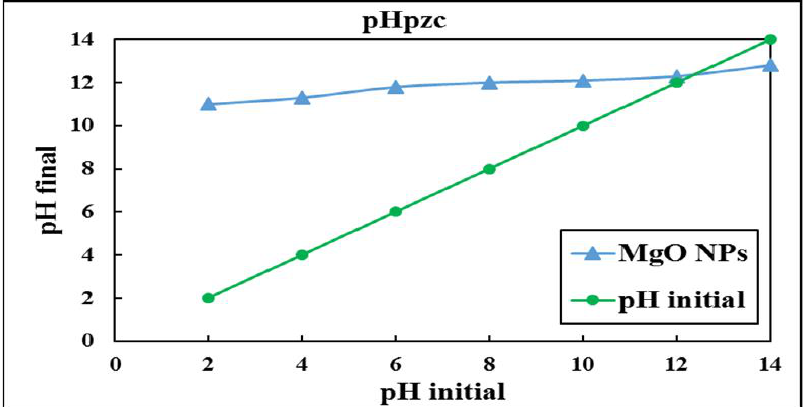
Figure 9. pH pzc determination of MgO NPs.